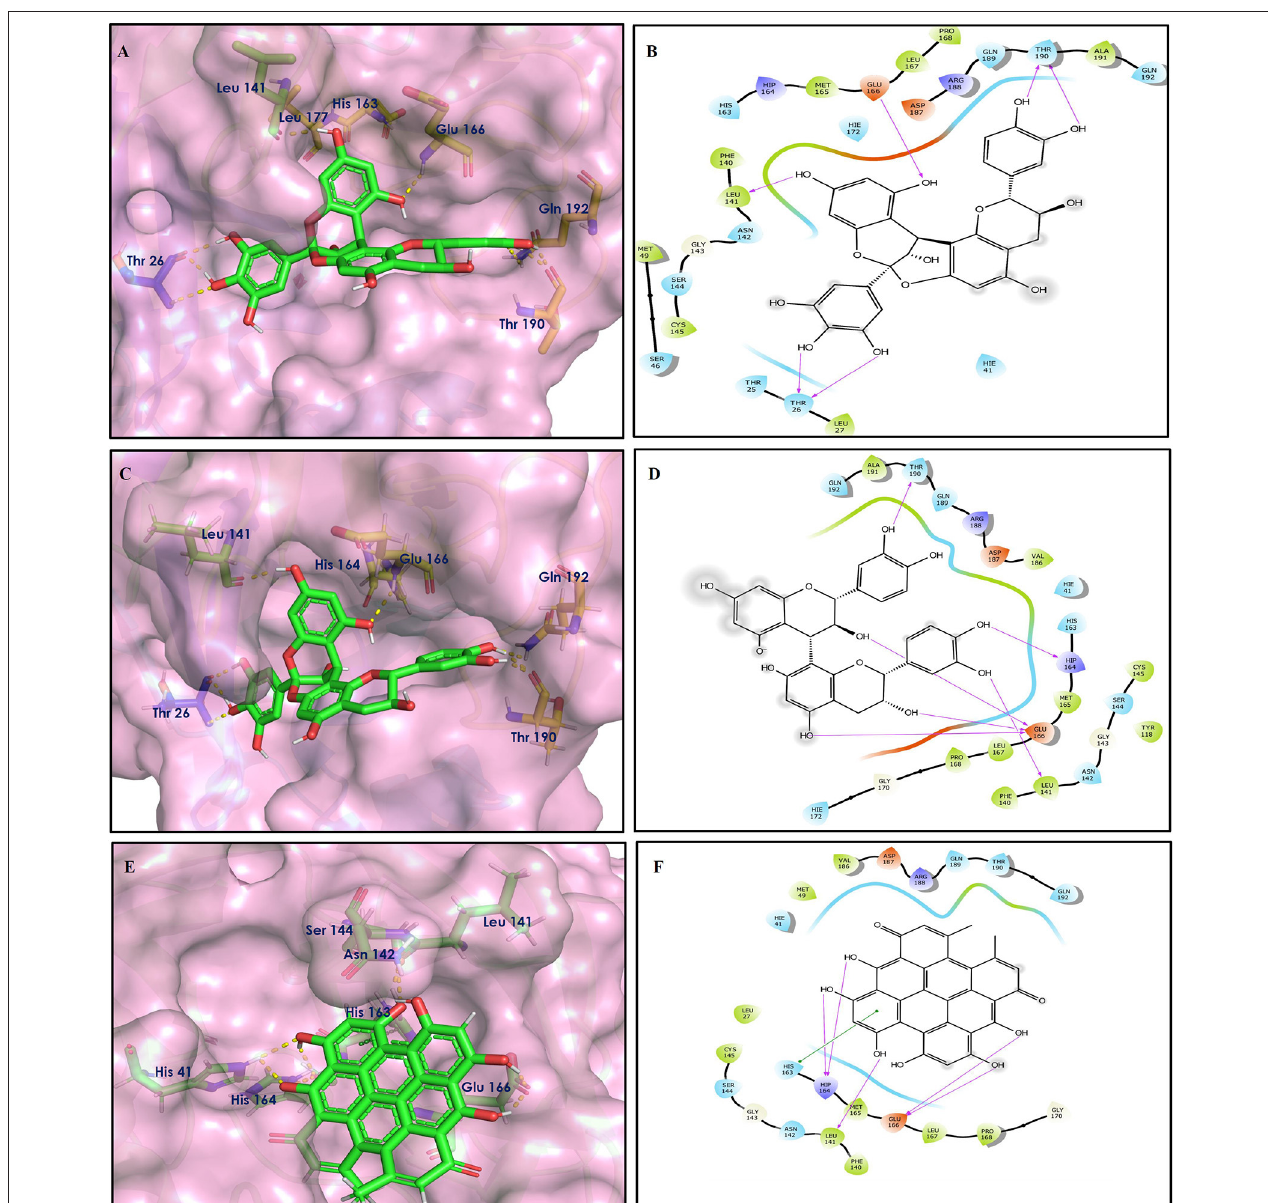
FIGURE 2 | Docking interactions of compounds (1, 3, 4 : A–F) in the active sites of Mpro. (A,C,E) 3D-binding mode of compounds 1 , 3 , and 4 with Mpro active site, respectively. Ligands are shown as green sticks, Mpro residues are shown as atom type color sticks, hydrogen bonds formed between ligands and receptor are depicted as yellow dotted lines. (B,D,F) 2D-ligand interaction diagram of compounds 1 , 3 , and 4 with Mpro active site, respectively.